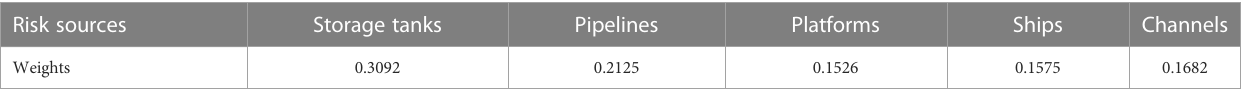
TABLE 2 Weight allocation